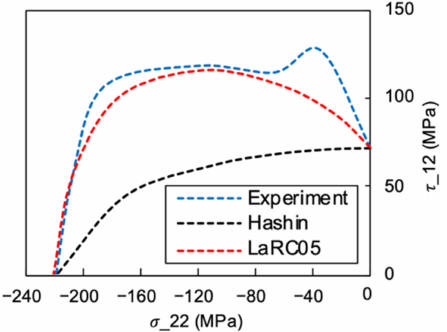
Figure 18. The off-axis compression failure